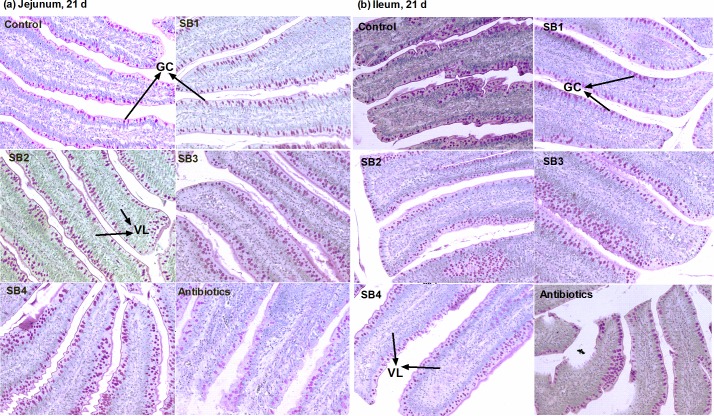
Villus morphology.Jejunum (a) and ileum (b) specimens were collected at 21 d, and PAS-stained sections were analyzed by optical microscopy at 200× for differences in villi (VL) length and quantity of goblet cells (GC).